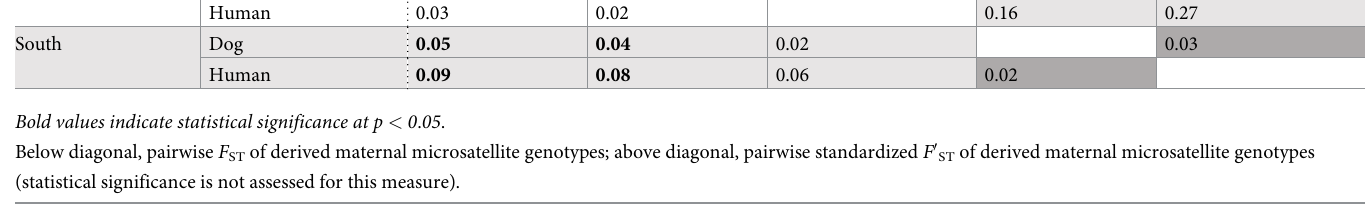
Table 5. Pairwise F ST Among derived maternal microsatellite genotypes in Chadian D . medinensis . North South Cat Dog Human Dog Human